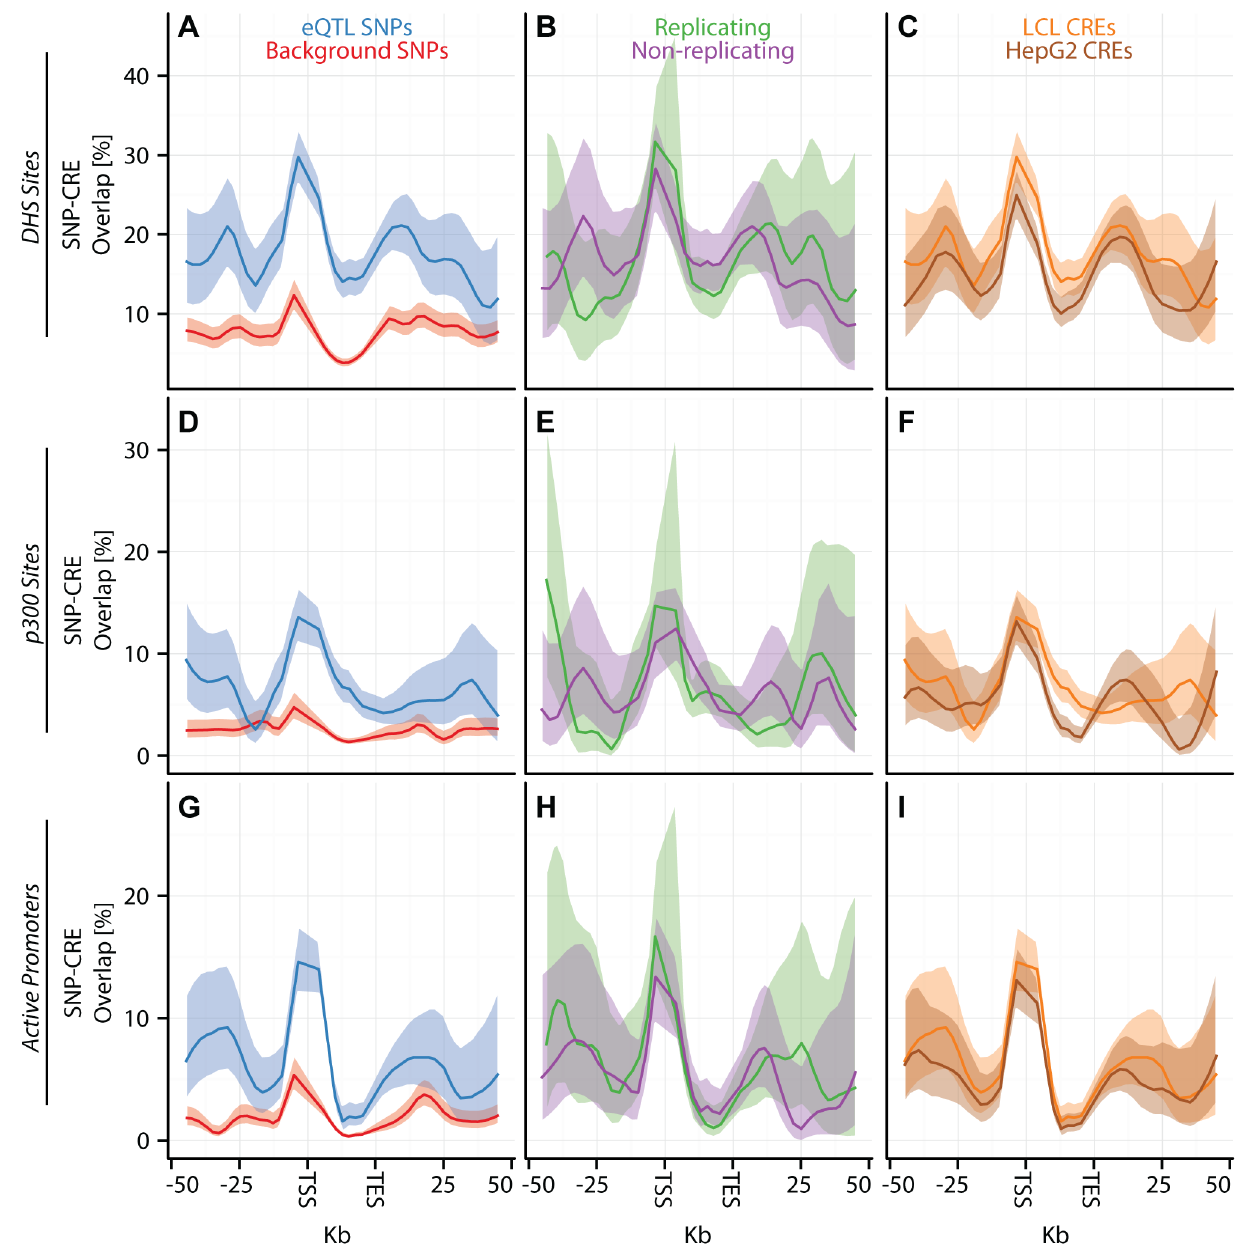
Figure 3. eQTL SNPs are enriched within activating cis-regulatory elements. (A–I) CAP_LCL eQTL SNP ( FDR ƒ 5% ) overlap with predicted cis-regulatory elements. Each row of panels depicts overlap with distinct CRE data sets: (A–C) DNAse hypersensitive sites, (D–F) p300 binding sites, (G–I) chromHMM predicted active promoters. In each panel, SNPs are grouped into 25 equally spaced bins within the 50 kb upstream and downstream of the TSS and TES, and 10 bins between the TSS and TES. Each bin is plotted along the x-axis. Bold lines depict the percentage, per bin, of SNPs overlapping the CRE class, ribbons depict 95% confidence interval. Each column of panels depicts a distinct SNP set contrast. (A,D,G) Observed eQTL SNPs (blue) and randomly drawn cis-linked SNPs at expressed genes (red). (B,E,H) eQTL SNPs that replicate in Stranger_LCL ( log 10 BF § 1 ) (green) and SNPs that fail to replicate (purple). (C,F,I) CAP_LCL eQTL SNP overlap with CREs derived from the LCL line GM12878 (orange) and HepG2 cells